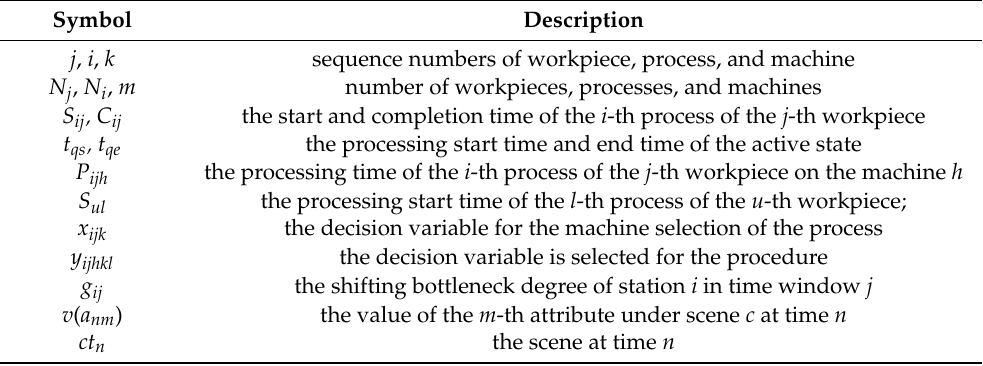
Table 2. Summary of bottleneck